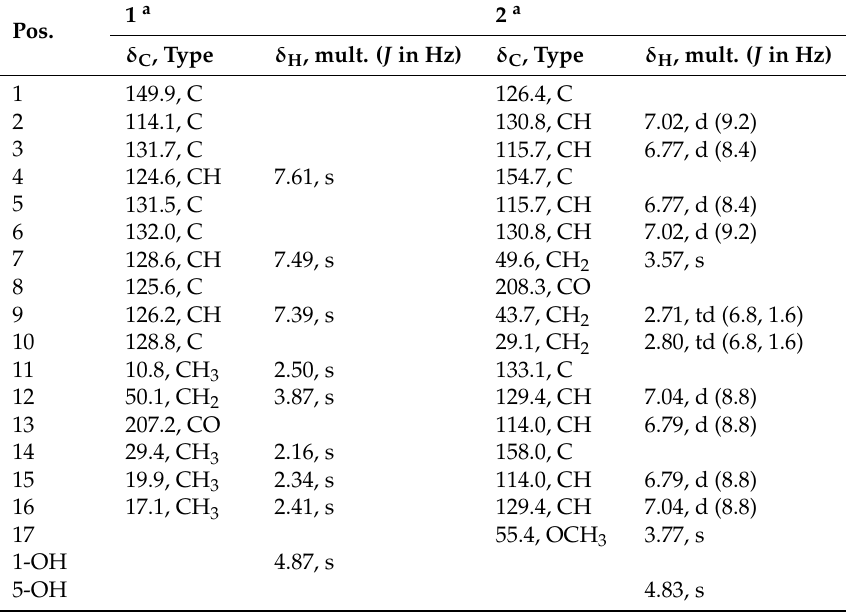
Table 1. 1 H- and 13 C-NMR data of compounds 1 and 2 at 400/100 MHz, respectively, δ in ppm.